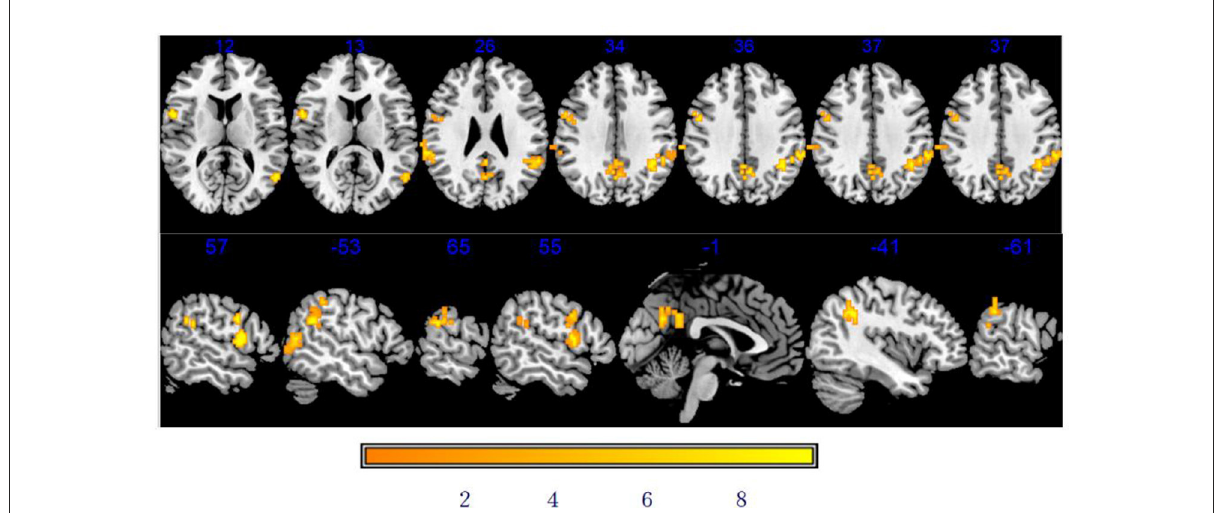
FIGURE4 Significant differences in DC between baseline and after stSCS in axial and sagittal slices. The warm colors indicate higher DC values at baseline and after stSCS ( p < 0.05). Brain images are presented in radiology convention (the left of the figure represents the right side of the patient’s brain and vice versa